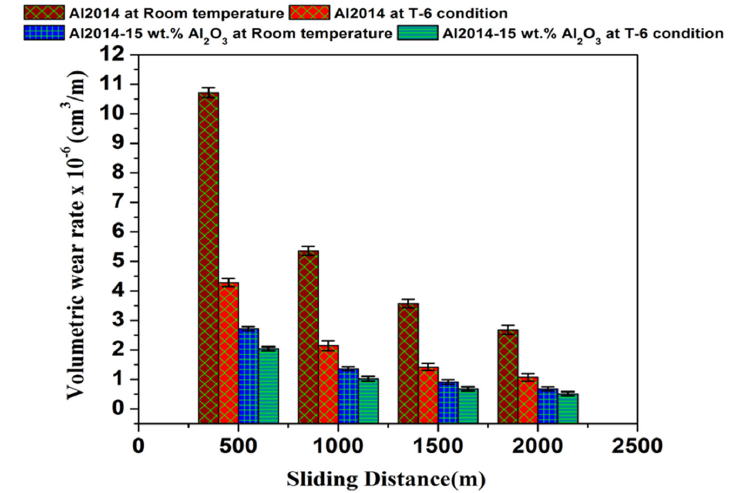
Figure 10. Impact of variable sliding distance on the volumetric wear rate of Al2014 and Al2014-15 wt.% Al 2 O 3 at both as-cast, T6 conditions, and error bar represents standard deviation.